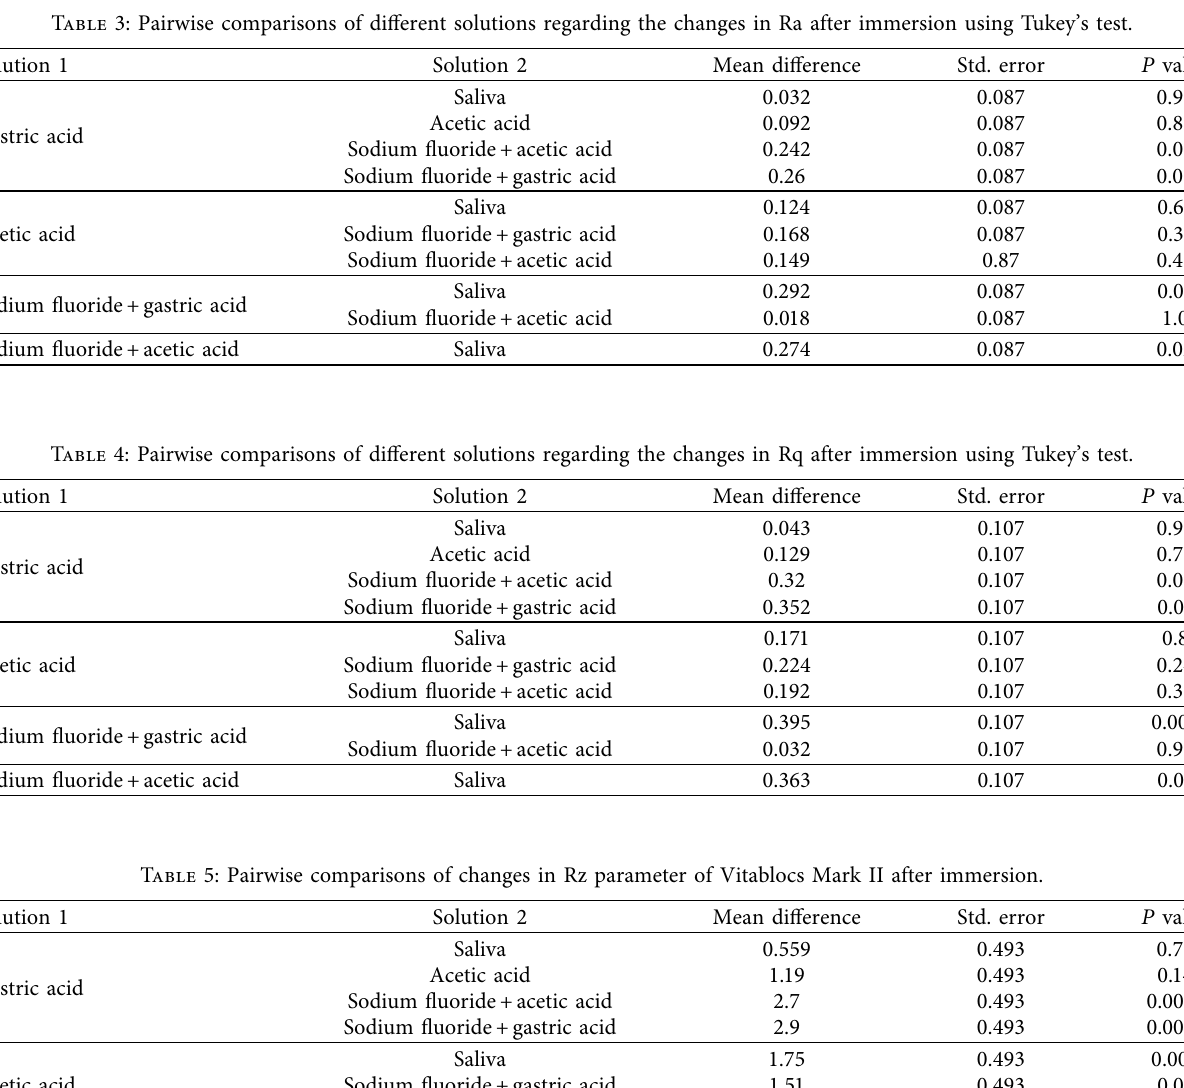
Table 3: Pairwise comparisons of different solutions regarding the changes in Ra after immersion using Tukey’s test.